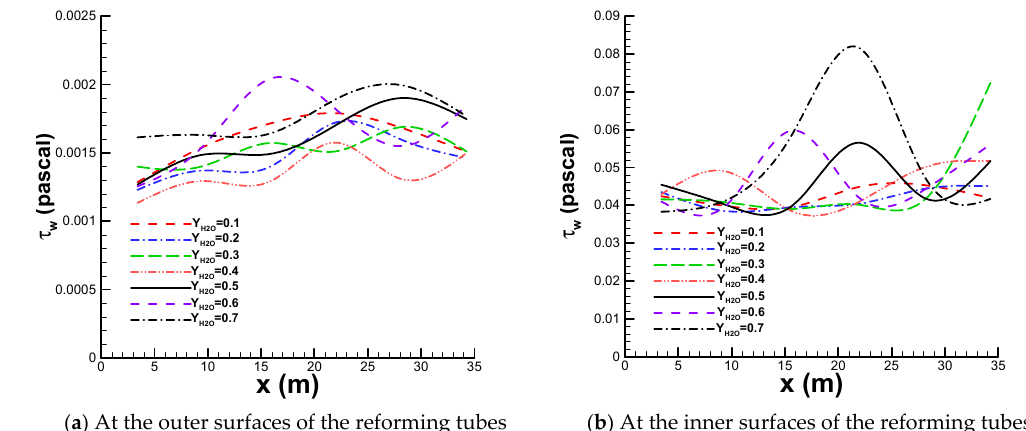
Figure 6. Comparison of the average wall shear stresses at the surfaces of the reforming tubes using different mole fractions of steam.